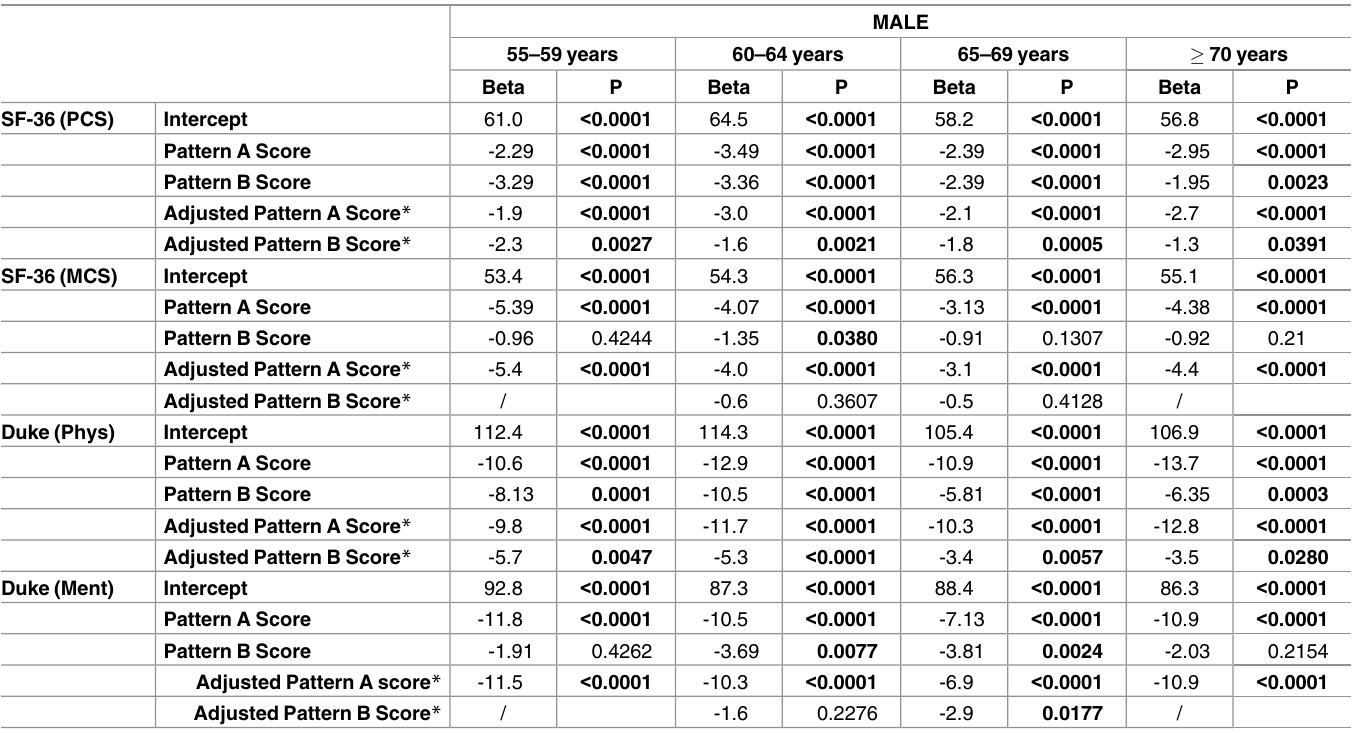
Table 5. Impact of multimorbidity on HRQoL for